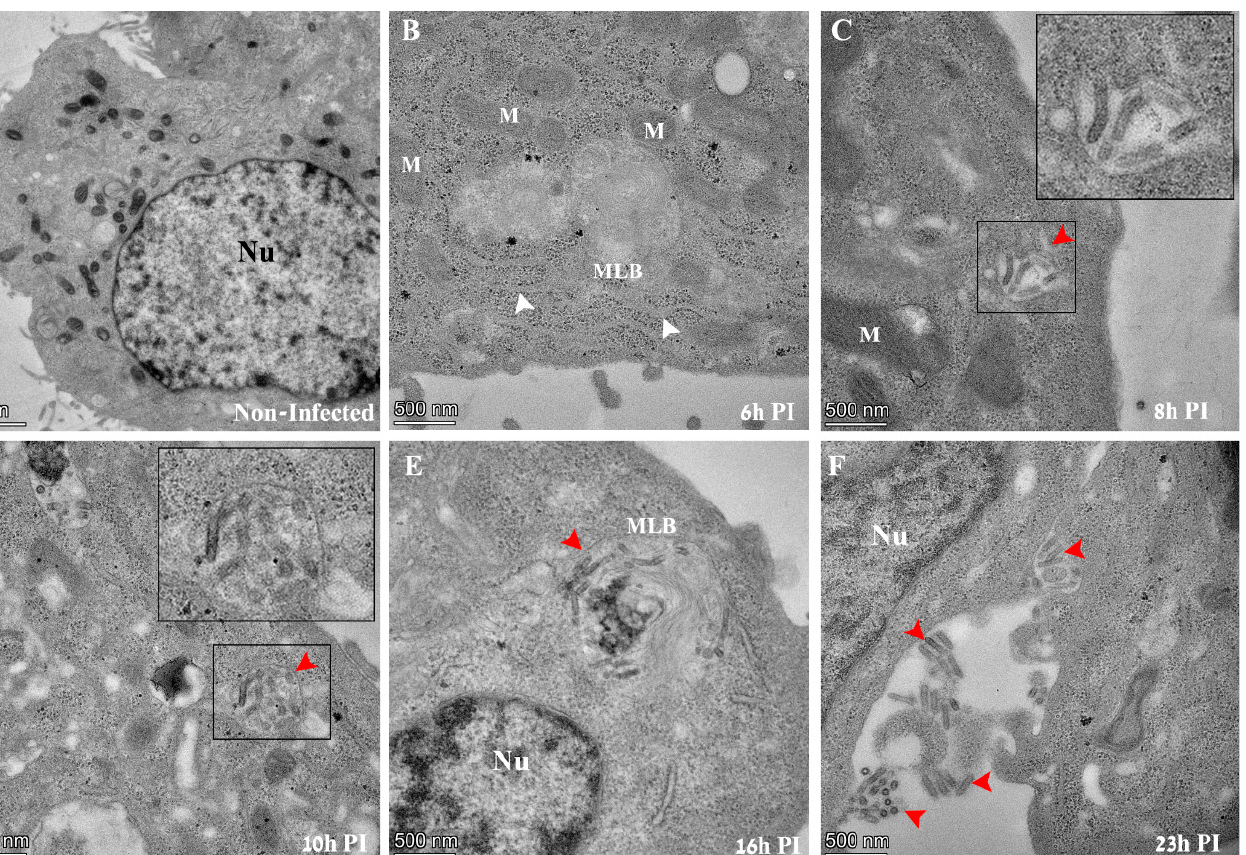
Figure 2. TEM images of thin sections prepared from Vero E6 cells infected with VSV-S. The cells were infected with the virus at an MOI of 1 and then processed by chemical fixation at the indicated time points post infection (PI). ( A ) Non-infected cells show no virus particles in the cytoplasm. The nucleus (Nu) of the cell is visible with surrounding mitochondria. ( B ) Six hours PI, a typical cell exhibits no virus particles in the cytoplasm. Membrane cisternae (white arrows), ribosomes, and multi lamellar bodies (MLBs) are frequently seen. ( C – F ). At 8–23 h PI, “bullet like” structures appear in vacuoles (panels ( C , D ), red arrows) in cytoplasmic MLBs (panel ( E ), red arrow), or adjacent to the outer leaflet of the plasma membrane (panel ( F ), red arrows). In panels ( C , D ), insets show high magnification of delineated areas. M—mitochondria, Nu—nucleus, MLB—multi lamellar bodies. Initial morphological evidence of infection could be seen at 8 h post infection (PI), when typical “bullet like” structures appear inside vacuoles in the cytoplasm of infected cells (Figure 2C, red arrow and inset). As infection extended to later PI time points of 10, 16 and 23 h PI, virus particles were seen in cytoplasmic vacuoles, multi-lamellar bodies (MLBs) or projecting out of the outer leaflet of the plasma membrane (Figure 2D–F, red arrows). The distinction between MLB and vacuoles is based on morphological features (discussed later). No virus particles could be seen at an early time point (6 h PI) or in non- infected cells in TEM sections (Figure 2A,B). As VSV-S is a pseudo virus, we assessed the morphological effect caused as a conse- quence of replacing the native G protein that of wild-type VSV, with the spike protein that of VSV-S. Supplementary Figure S2 shows the results from thin section TEM analysis of wild-VSV and VSV-S infected Vero E6 cells. As can be seen, the classical “bullet” shaped VSV particles (white inset in panel A) were seen in cytoplasmic sites devoid of host orga- nelles and ribosomes, and surrounded by host membranes (blue arrows ). In addition, virus particles with various morphologies were frequently seen in cytoplasmic vacuoles (Supplementary Figure S2, panels C,D) [30], similar to VSV-S (Supplementary Figures S2 panels, E,F and Figure 2C,D).